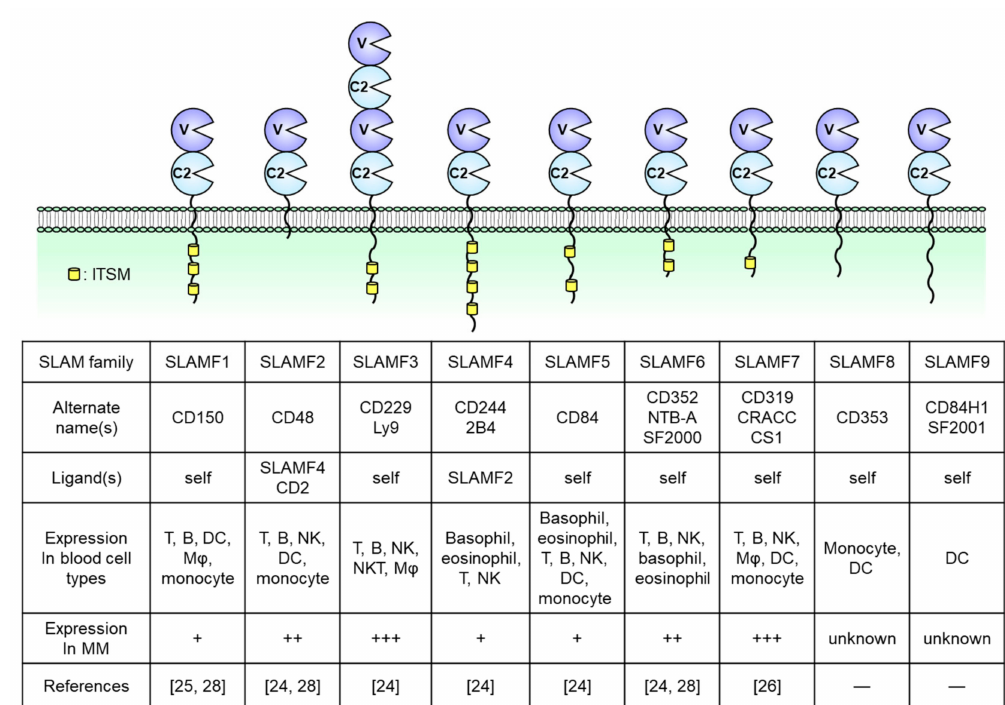
Figure 1. Structures of nine signaling lymphocytic activation molecule (SLAM) family receptors. The extracellular regions contain IgV (V)- and IgC2 (C2)-like domains. The receptors bind to self-ligands with high affinity through the IgV-like domain. In all family members except for SLAMF2, SLAMF8, and SLAMF9, the cytoplasmic tail contains an immunoreceptor tyrosine-based switch motif (ITSM). The expression of immune cells is from the database of the Human Protein Atlas (https://www.proteinatlas.org/). DC, dendritic cell, M ϕ , macrophage, NK, natural